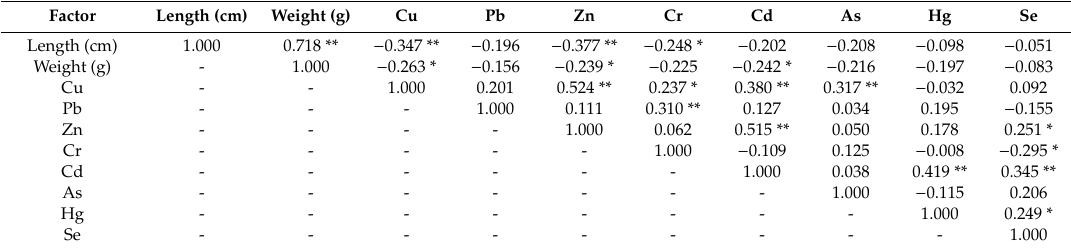
Table 4. Correlation matrix between the characteristics of fish and concentration of metals in fish. Factor Length (cm) Weight (g) Cu